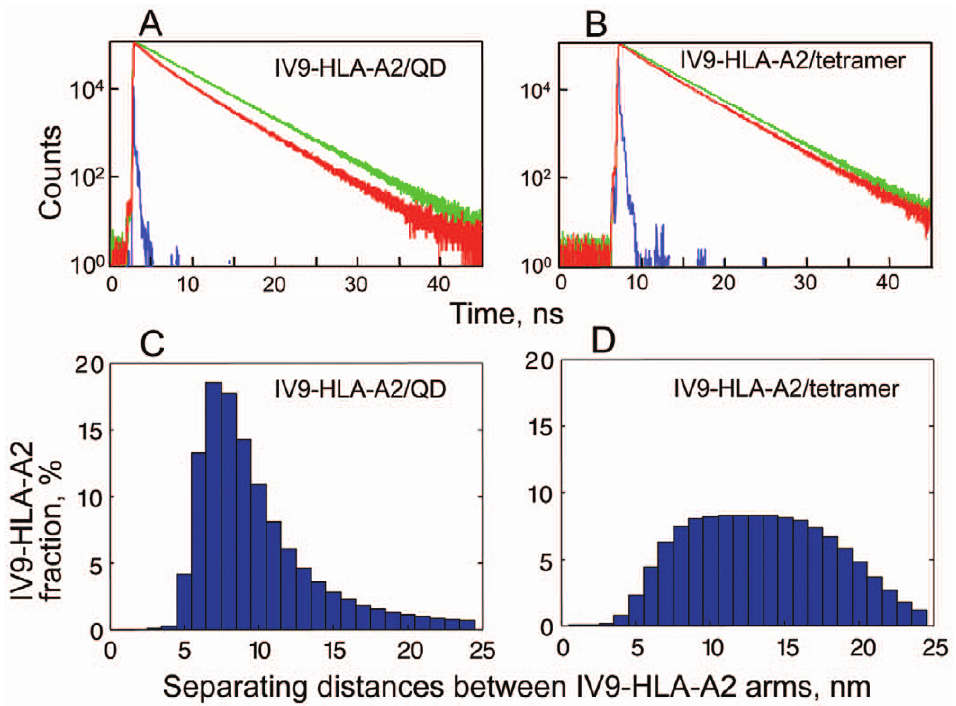
Figure 3. Distribution of separating distances between IV9-HLA-A2 proteins assembled on QD and Streptavidin scaffolds. Fluorescence decay of AF594-IV9 peptide bound to HLA-A2 protein (donor) in the presence or absence of AF647-IV9-HLA-A2 protein (acceptor) displayed on the surface of QD(520) ( A ) or Streptavidin scaffold ( B ). Fitting the experimental data to the model (Eqs. 1–7) yielded satisfactory fit ( x 2 , 1.2) allowing to evaluate distribution of separating distances between IV9-HLA-A2 molecules displayed on QD ( C ) or Streptavidin ( D ).